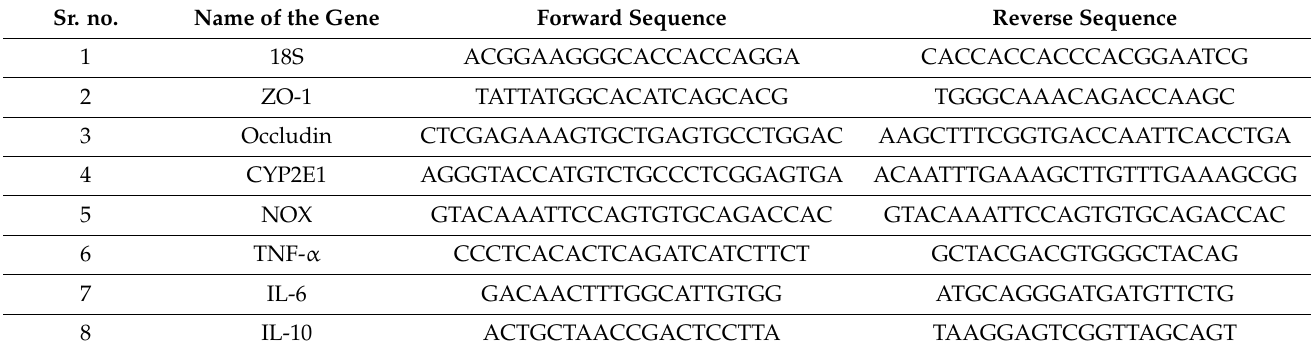
Table 1. Human Colorectal adenocarcinoma Caco-2 cells primers list.